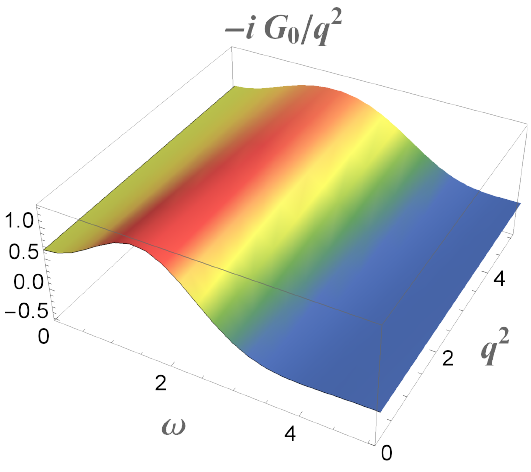
Figure 6 . The ω -, q 2 -dependence of − iG 0 ( ω, q 2 ) /q 2 .